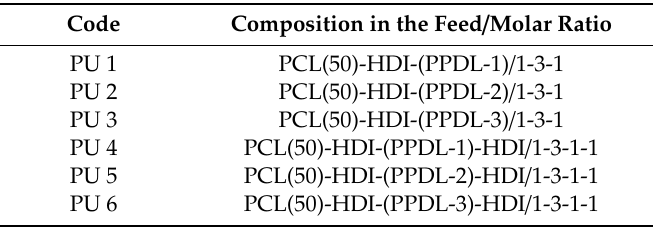
Table 1. The compositions of samples PU 1–PU